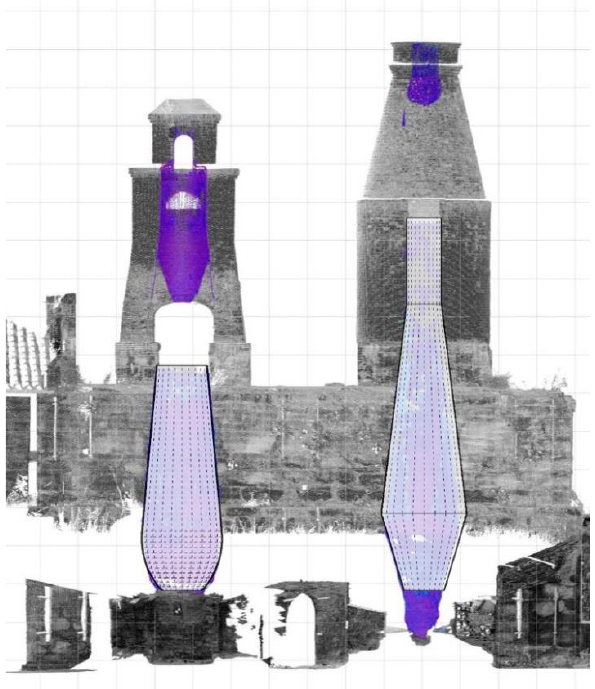
Figure 8: models of the two blast furnaces on raster base with 1mx1m grid (digital elaboration by the authors).